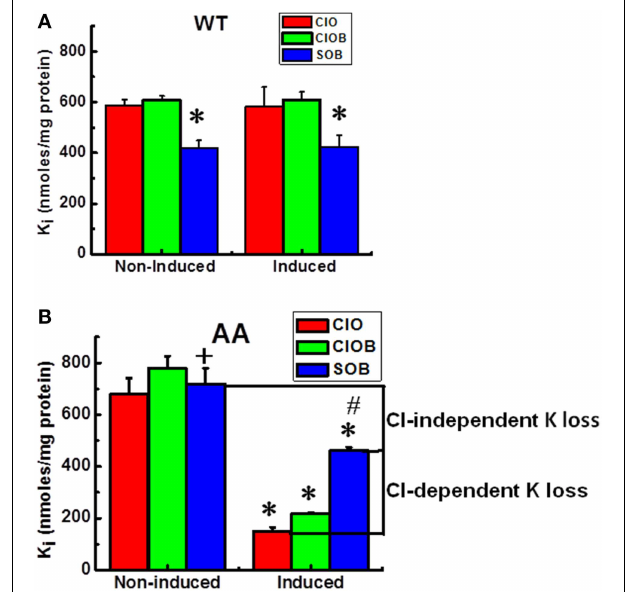
FIGURE 4 | Constitutive KCC3 Thr991/Thr1048 dephosphorylation elicits rapid and potent Cl-dependent and Cl-independent K i loss. K i after flux in 10mM RbCl with ouabain (ClO); ouabain + bumetanide (ClOB); and in 10mM RbS with ouabain + bumetanide (SOB) in the indicated cell lines [ A (WT), B (AA)] before and after induction with doxycyline. Induction of KCC3 AA results in a large decrease in K i via K + efflux through KCC3. Use of the Cl-free medium SOB partially reduces the magnitude of this K i decrease, indicating that there are both Cl-dependent and Cl-independent components of the K i decrease stimulated by KCC3 AA induction. Cl-dependent K + loss in induced cells was calculated as the K i content in SOB—that in ClO, whereas the Cl-independent K + loss was calculated as the difference in K i content in SOB between non-induced and induced cells. Flux time, 5min; n = 9 individual determinations from a single experiment for WT and n = 4 for AA cells. Total number of independent experiments N = 4 for WT and N = 2 for AA cells. There was a statistically significant difference between groups as determined by Kruskal–Wallis One-Way ANOVA for Non-induced vs. Induced (ClO, ClOB, and SOB) for WT [ F (5 , 48) = 21 . 55 ] and AA [ F (5 , 18) = 36 . 97 ], p < 0 . 0005 , n = 54 and 24, respectively. These differences were confirmed